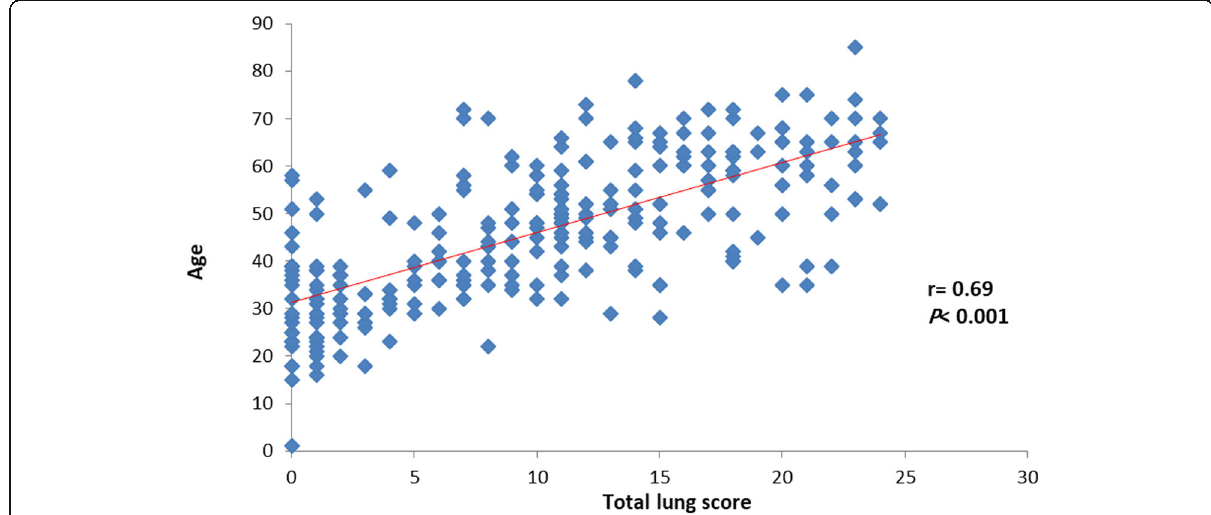
Fig. 3 Correlation between total lung score and age in female